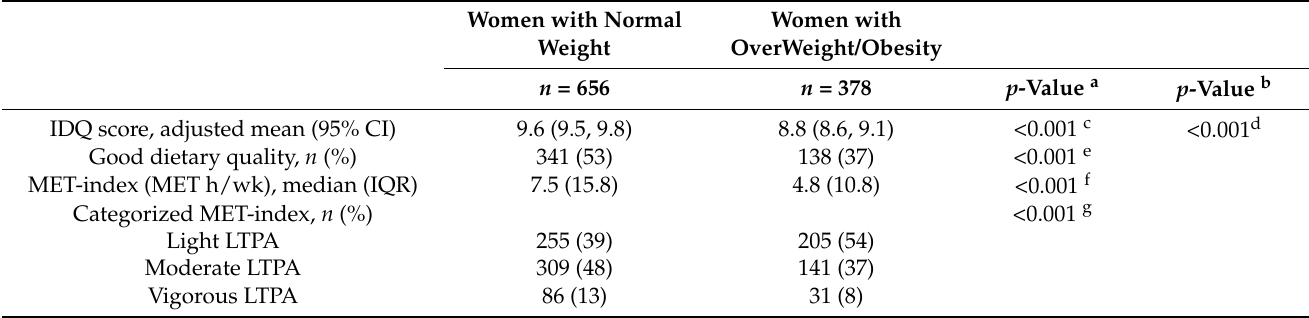
Table 4. Dietary quality and physical activity in the women with normal weight and in the women with overweight/obesity. Women with Normal Women Weight